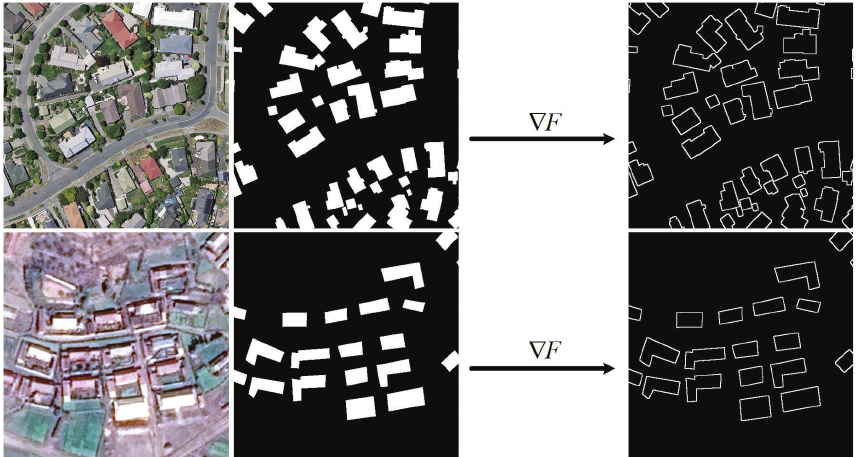
Figure 3. Some visualization examples for the segmentation mask and inferred semantic boundary through spatial variation